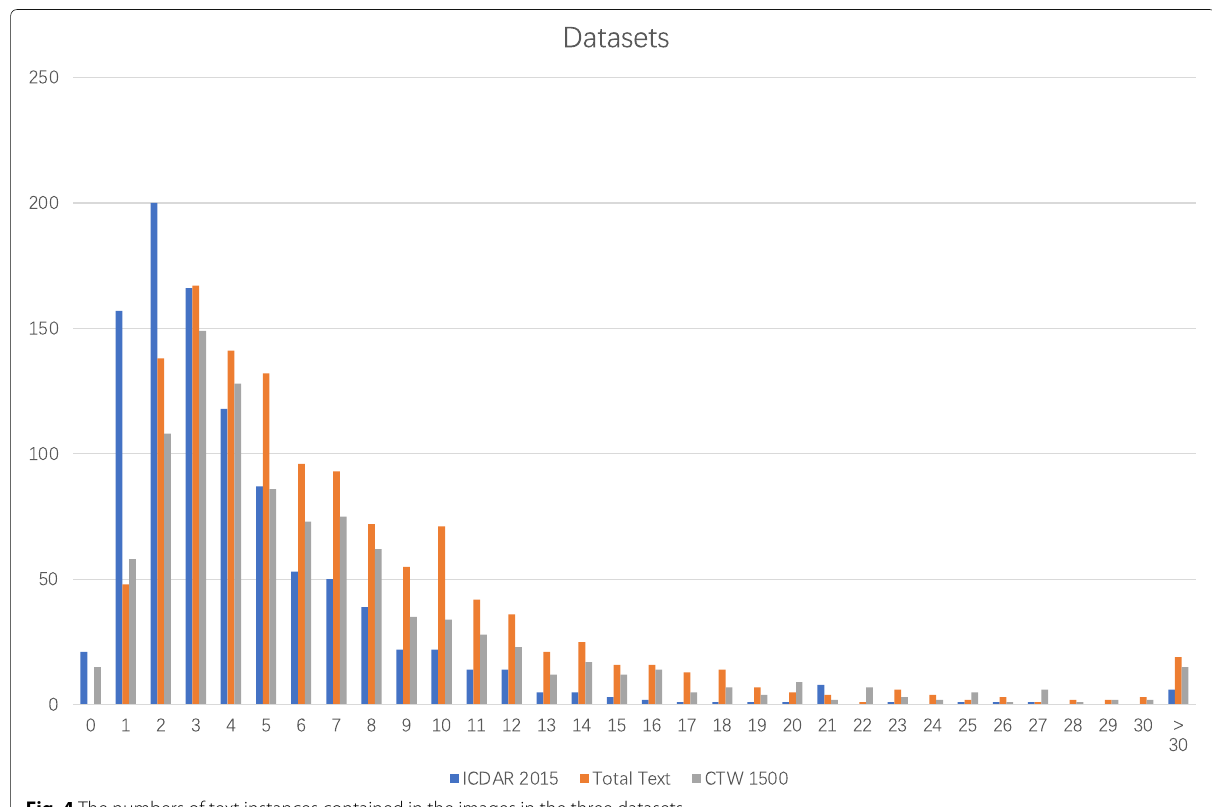
Fig. 4 The numbers of text instances contained in the images in the three datasets